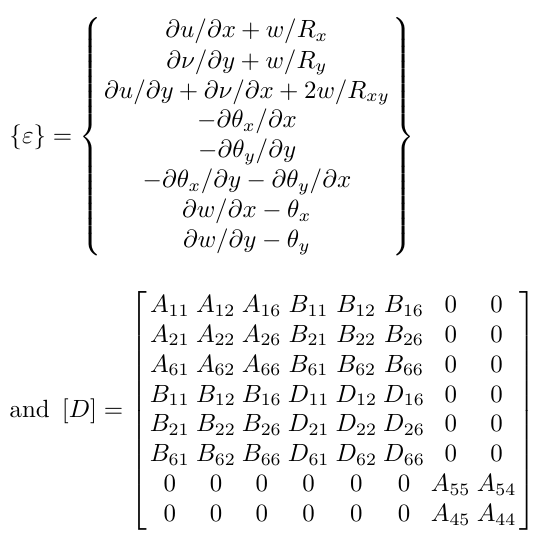
a Analysis based on proposed element using MLS-1 as the mass lumping scheme.